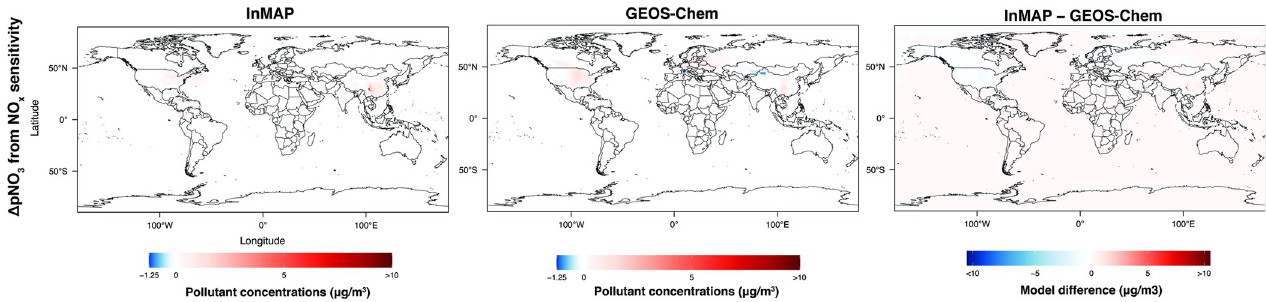
Fig 11. Comparison between Global InMAP and GEOS-Chem for predicting changes in pNO 3 concentrations from a 100% increase in NO x emissions from road transportation.